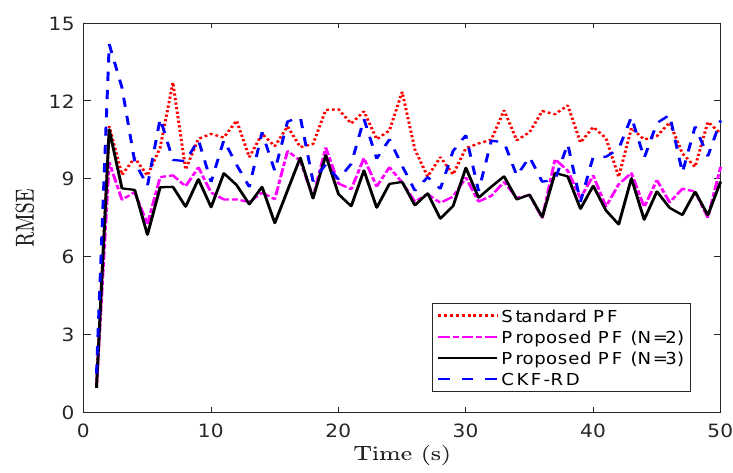
Figure 4. RMSE of different filters for N = 3 and p = 0.50 (problem 1).